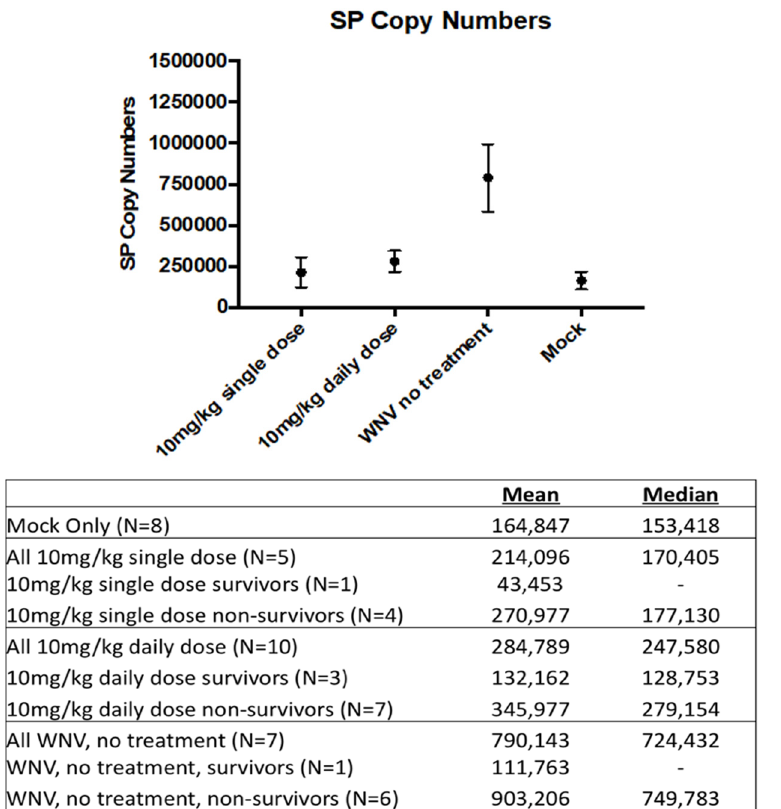
Figure 5. Comparison of SP levels between treatment groups at time of euthanasia. Means are expressed with the standard error. SP levels correspond to the number of SP RNA copies per µL of RNA. For these reactions, 2 µL of RNA was used.